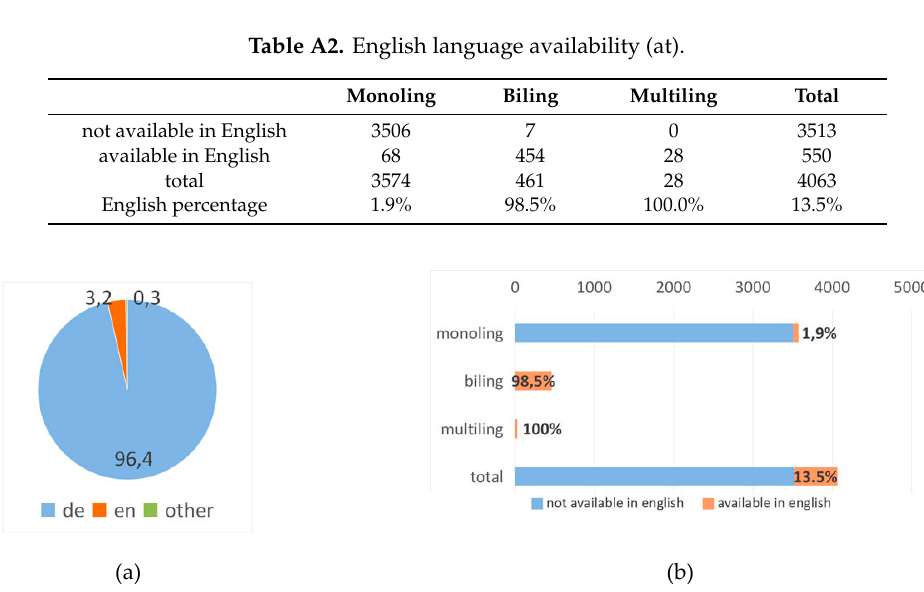
Figure A1. Visualization of the results for domain at. ( a ) Primary languages pie chart and ( b ) English language availability bar chart.